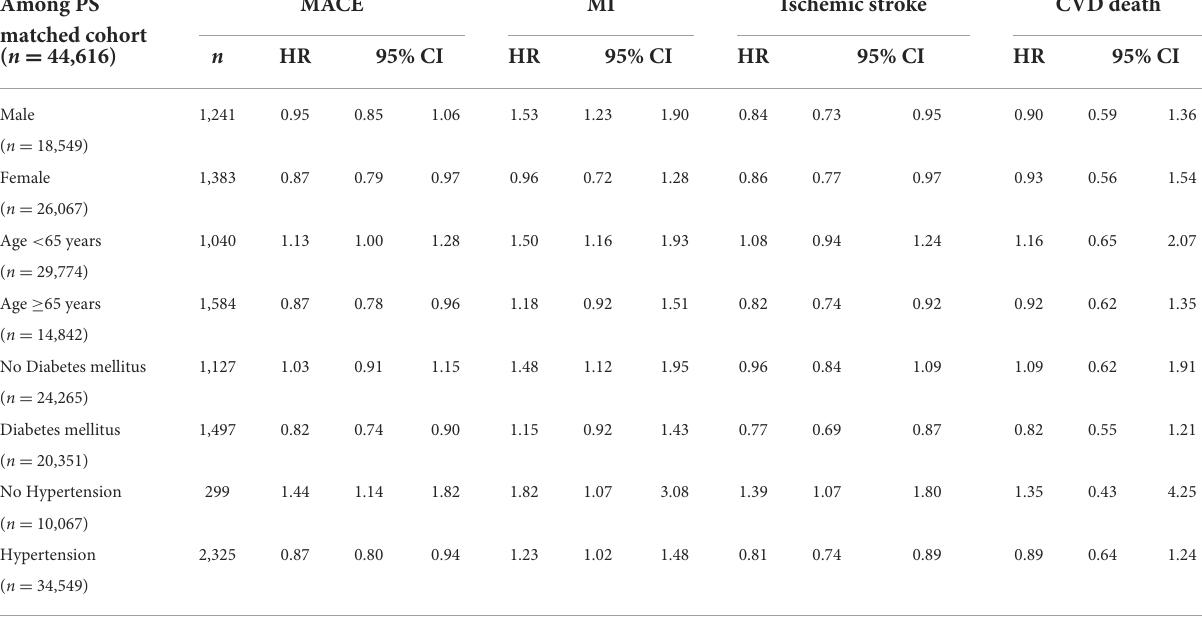
TABLE 4 Hazard ratio of MACE by